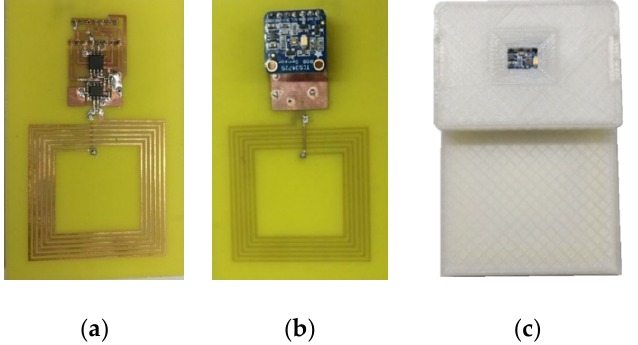
Figure 3. Photograph of the tag prototype: ( a ) Front side, ( b ) back side, ( c ) tag within the 3D printed enclosure.